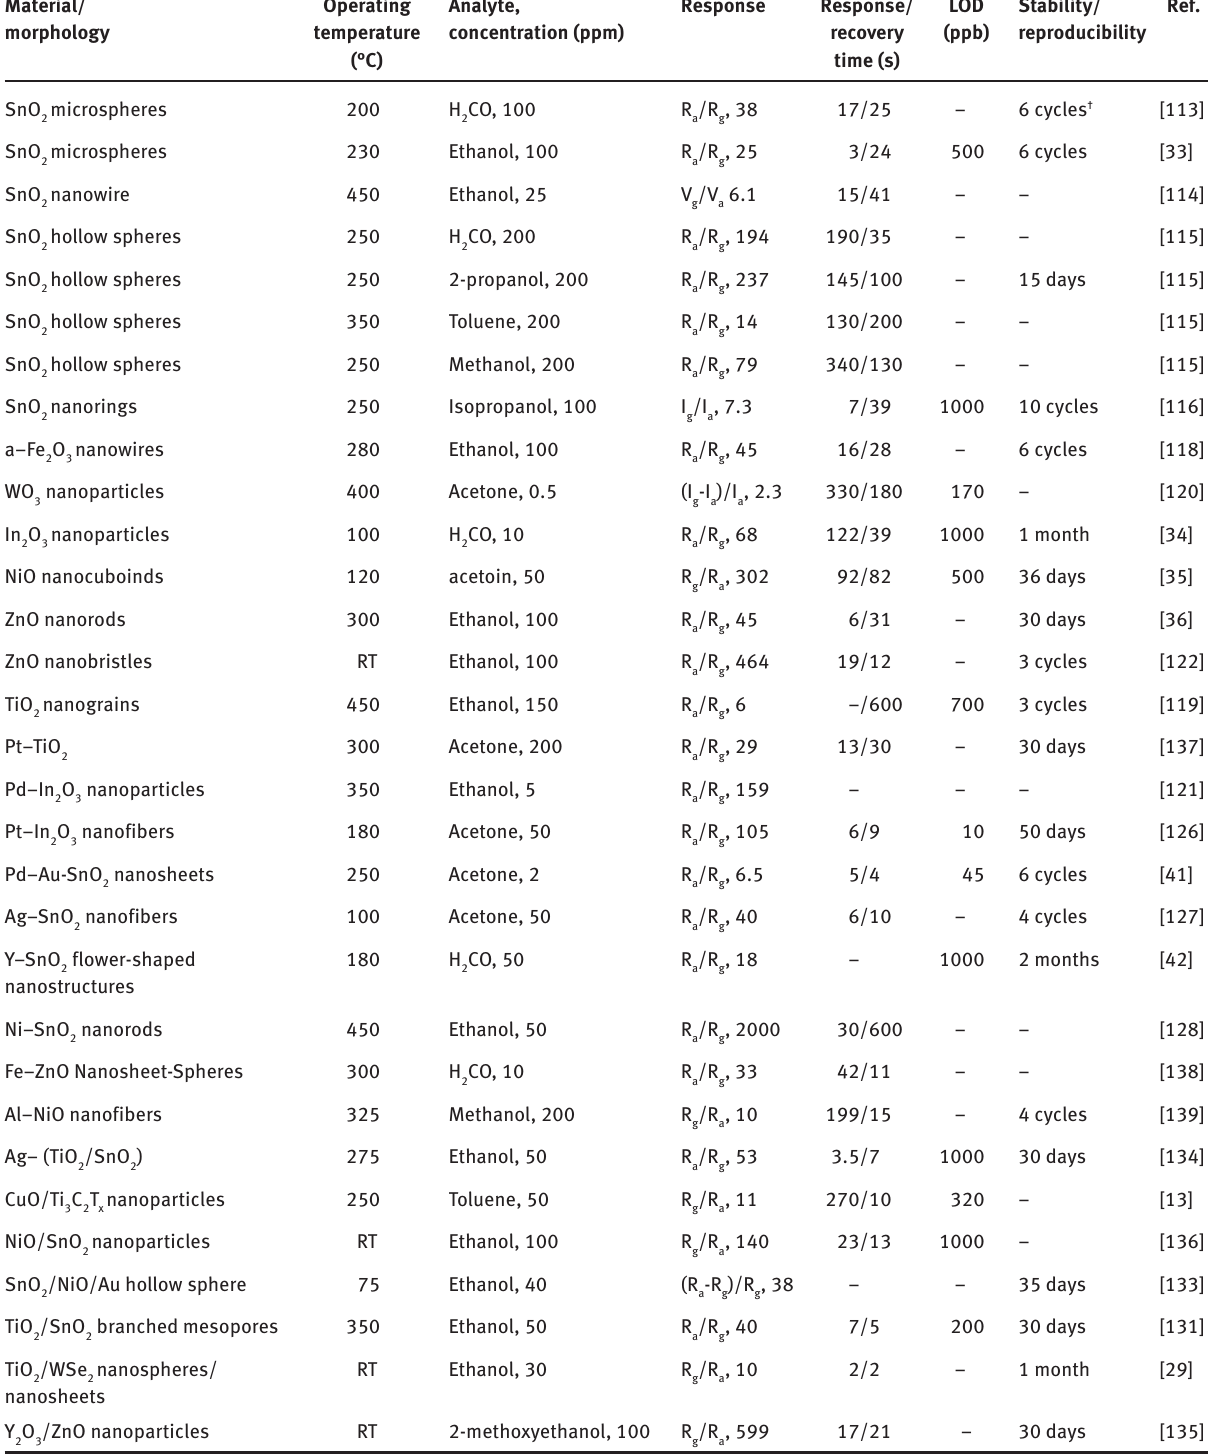
Table 1: Sensing parameters of metal oxide nanostructures for the detection of VOCs at their optimum operating conditions Material/